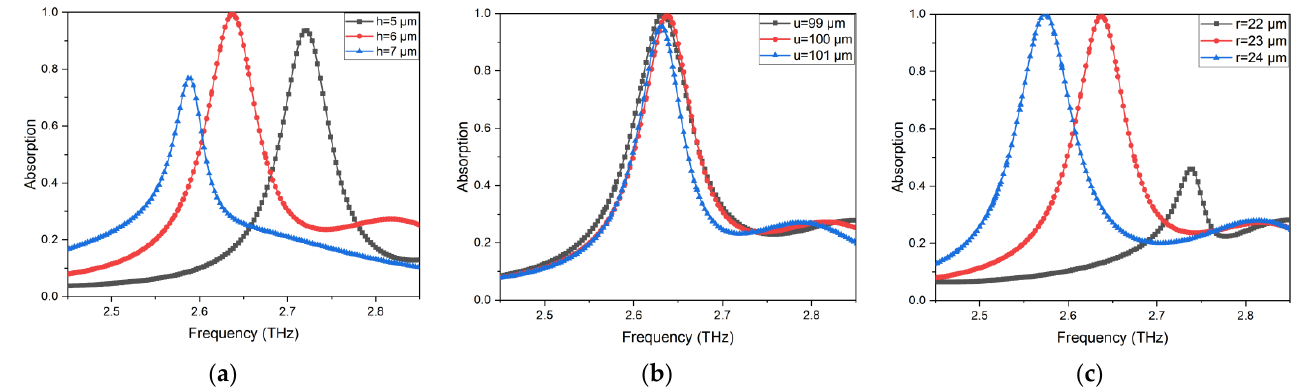
Figure 5. Parametric analysis for ( a ) thickness of the substrate; ( b ) dimension of the unit cells; ( c ) radius of the circular patches.